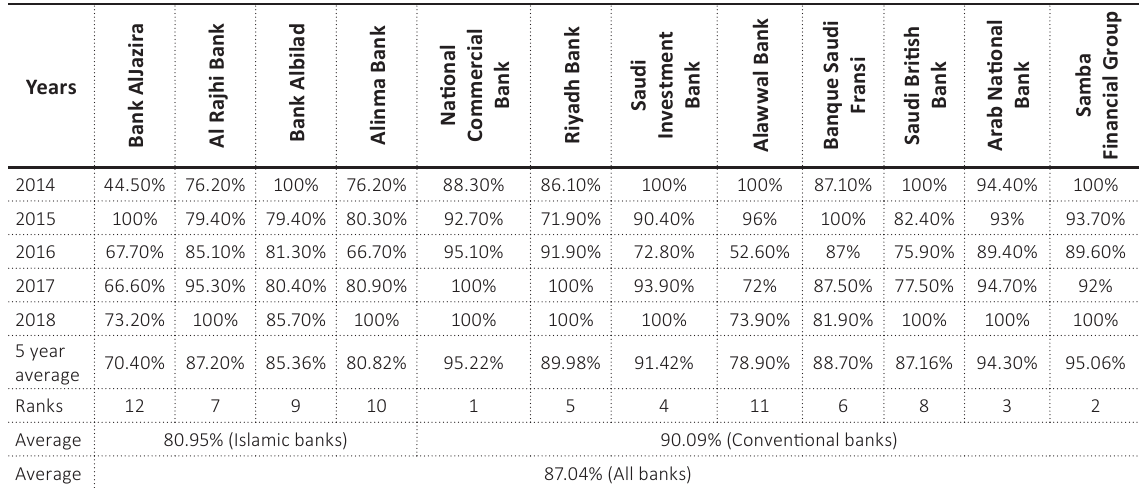
Table 3. Efficiency